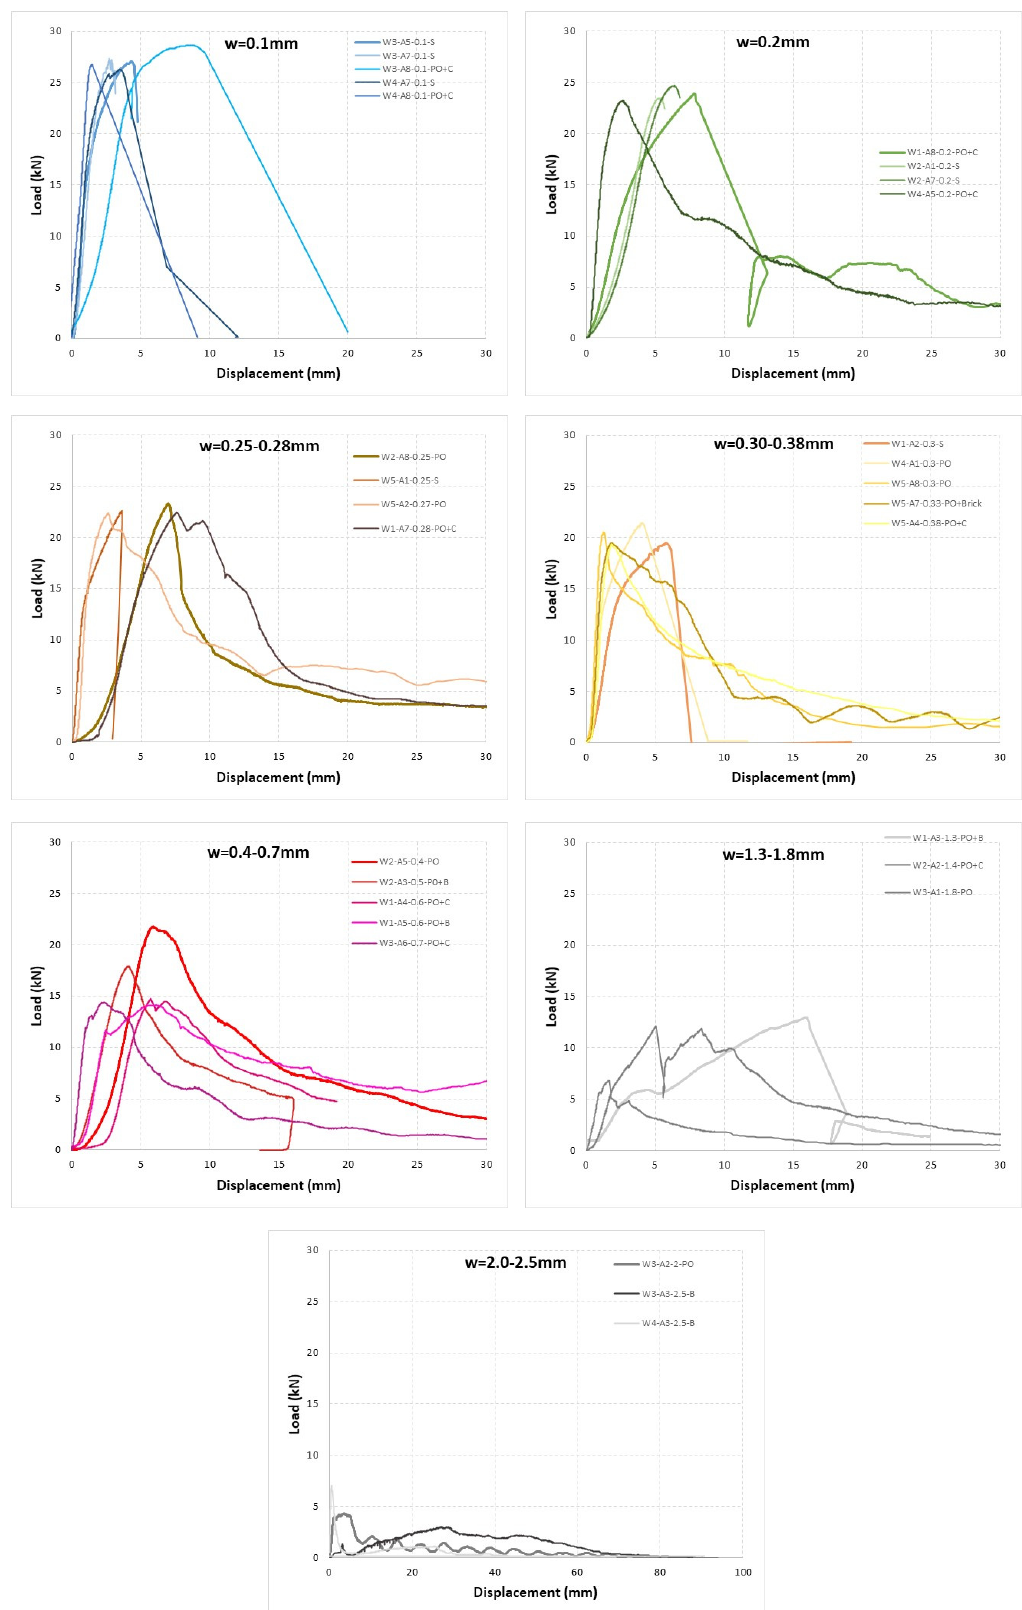
Figure 12. Load-Displacement curves grouped by crack width (Test Code-crack width in mm-type of failure).